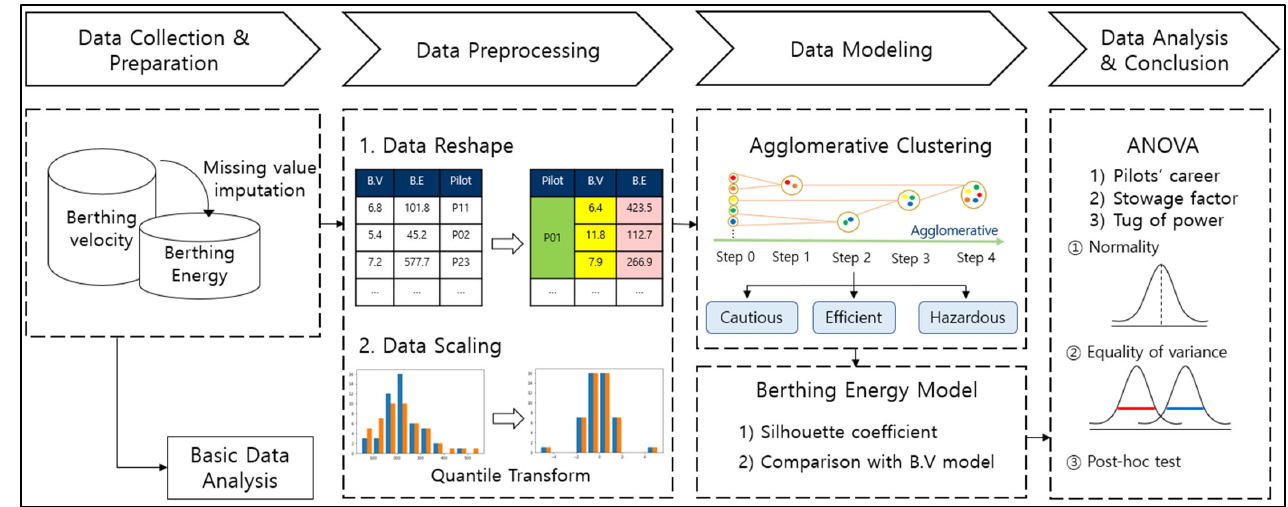
Figure 1. Research flowchart.